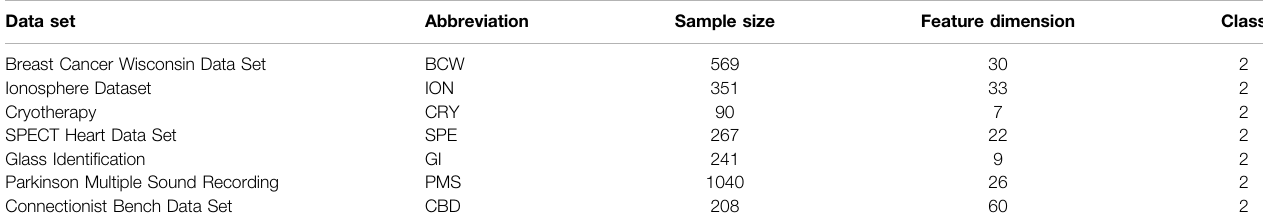
TABLE 1 | Relevant information of the public data